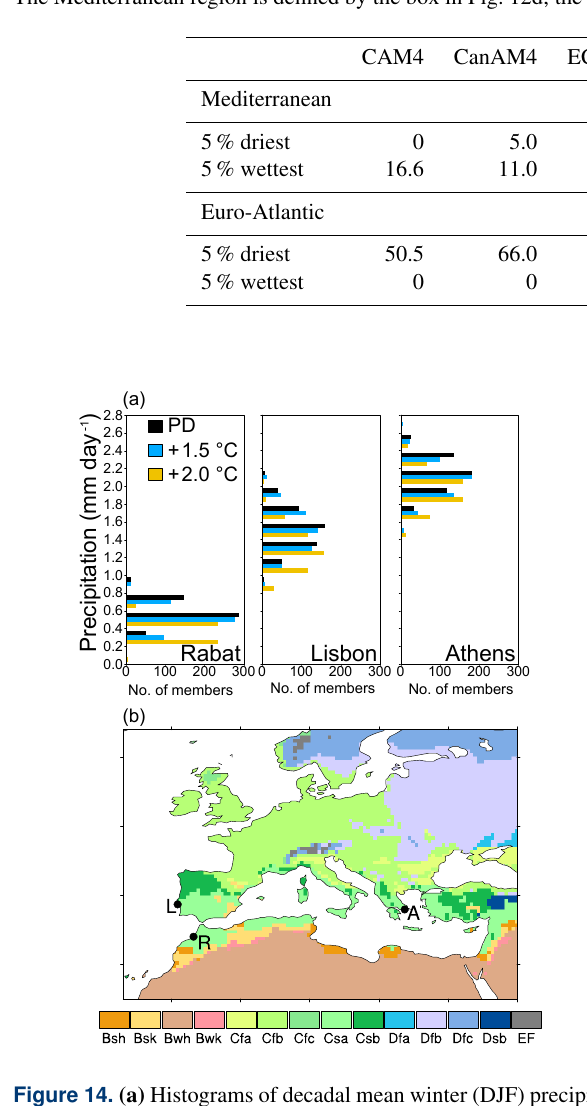
Figure 14. (a) Histograms of decadal mean winter (DJF) precipita- tion in Rabat, Lisbon, and Athens for the PD and 1.5 and 2.0 ◦ C experiments from the CAM4 ensemble. The locations are indi- cated in (b) as well as in Fig. 13. (b) Climate zones according to the Köppen–Geiger classification scheme (Kottek et al., 2006). The Mediterranean is primarily a temperate zone with dry summers (Csa, Csb) but includes some arid regions (BSk, BSh).